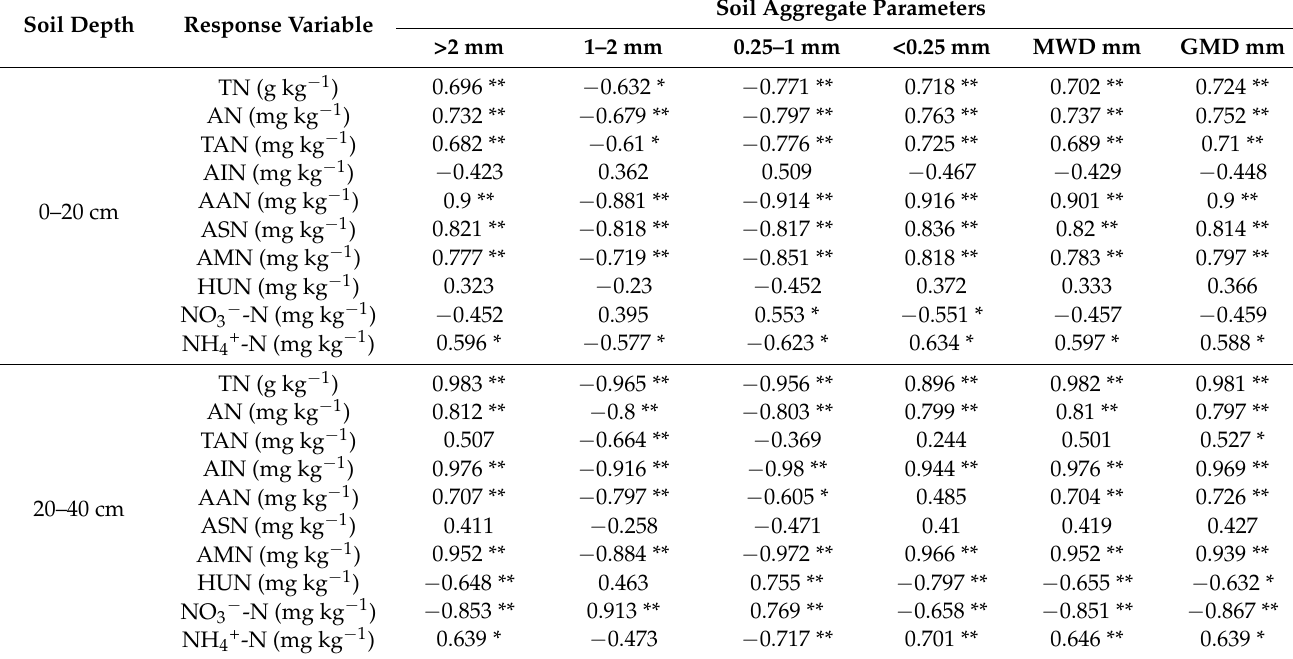
Figure 6. Redundancy analysis of soil nitrogen content and soil properties in Chinese fir plantations with different stand types in 0–20 cm ( A ) and 20–40 cm ( B ) soil depth. TN, AN, NO 3 − -N, NH 4+ -N, TAN, AIN, AAN, ASN, AMN, and HUN represent the total nitrogen, available nitrogen, nitrate nitrogen, ammonium nitrogen, total acidolyzable nitrogen, nonacidolyzable nitrogen, amino acid nitrogen, amino sugar nitrogen, cidolyzable ammonia nitrogen, and unknown-acidolyzable nitrogen contents in bulk soil, respectively. MWD and GMD represent the mean weight diameter and geometric mean diameter, respectively. <0.25, 0.25–1, 1–2, and >2 represent proportions of the micro-, small-, medium-, and macro-aggregates, respectively. Table 4. Pearson’s correlation of soil N content and soil aggregate